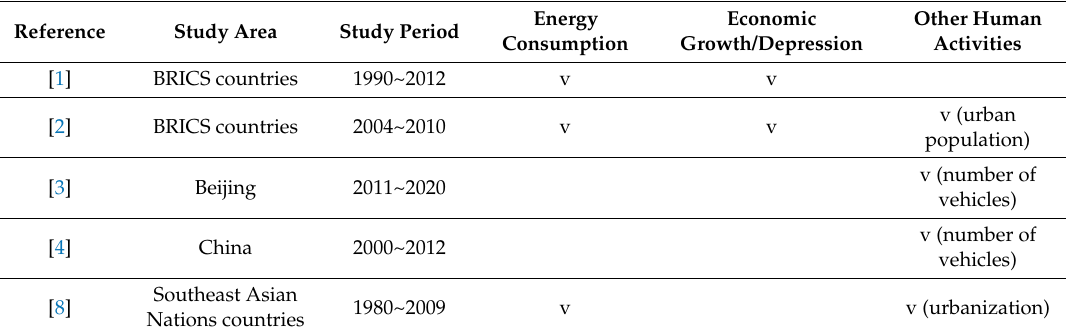
Table 1. Comparison of previous studies on factors that affect carbon